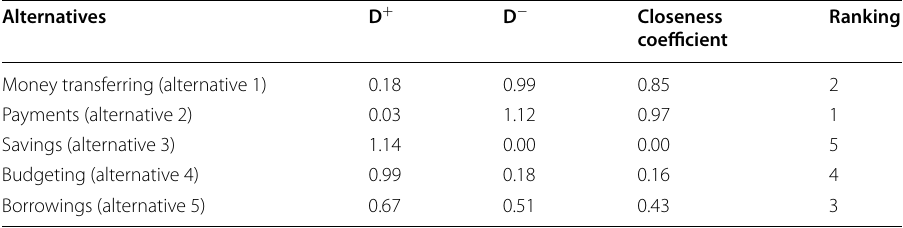
Table 7 Closeness coefficient and ranking results for the alternatives. Source : Author’s